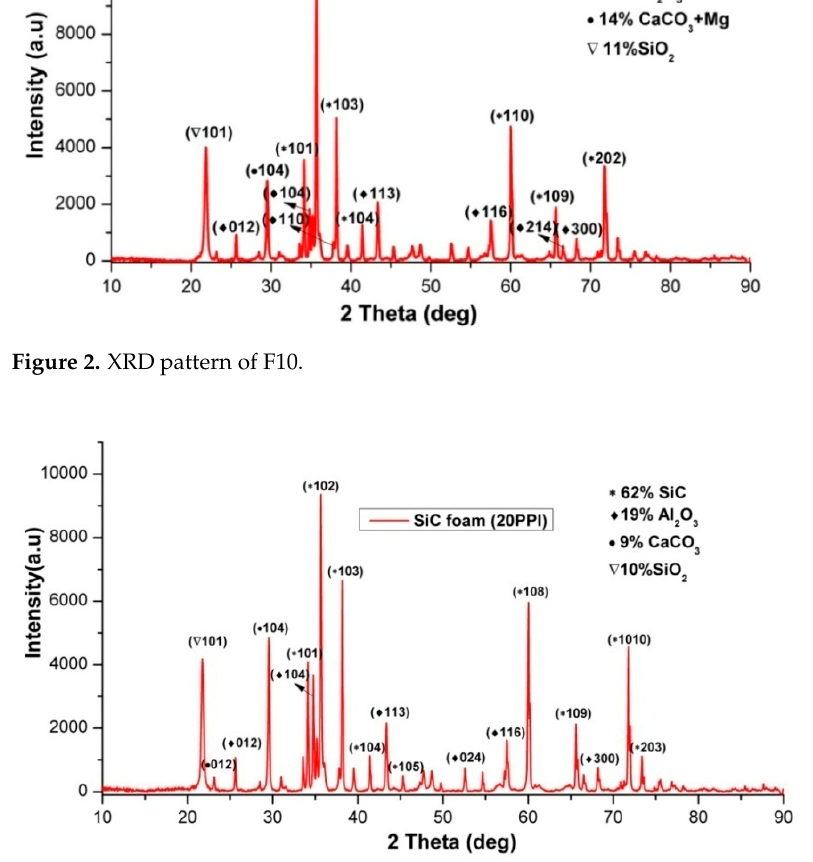
Figure 3. XRD pattern of F20. Table 3. Weight fraction of phases.